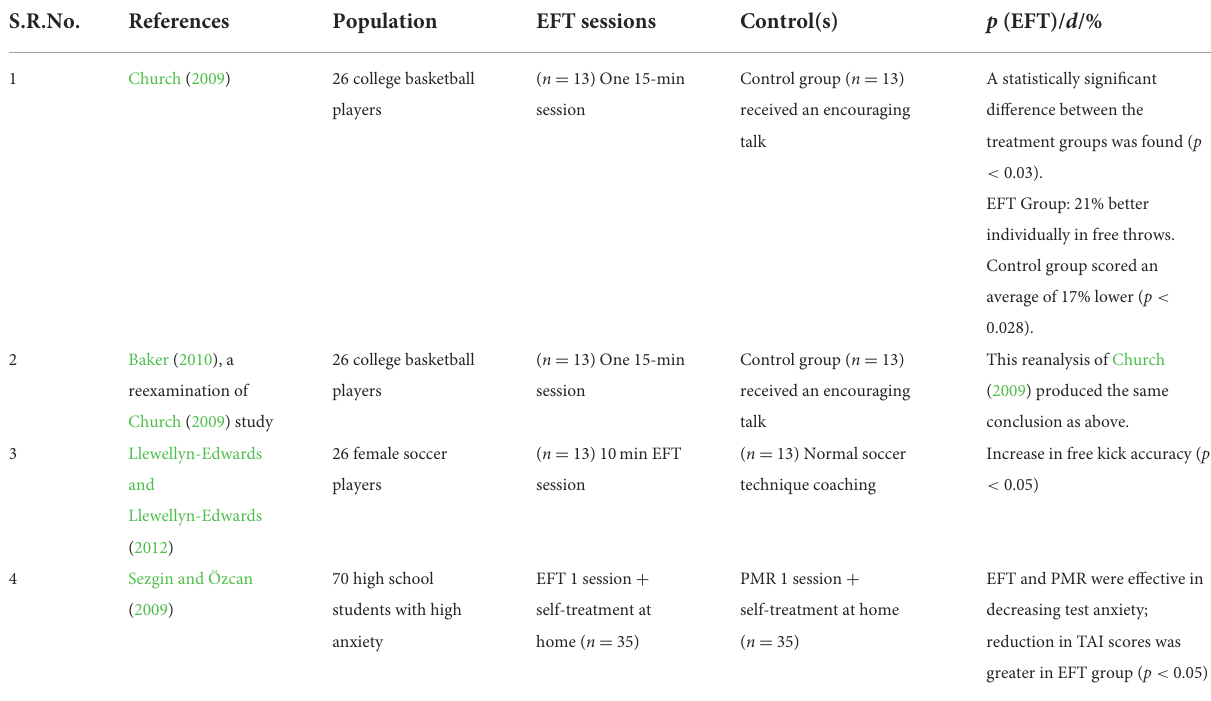
TABLE 15 Sports and other performance RCTs.